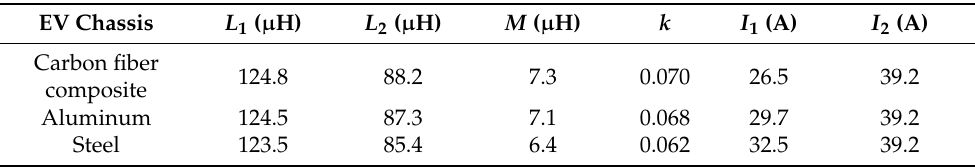
Table 3. WPT lumped inductances and r.m.s. currents at 150 kHz.